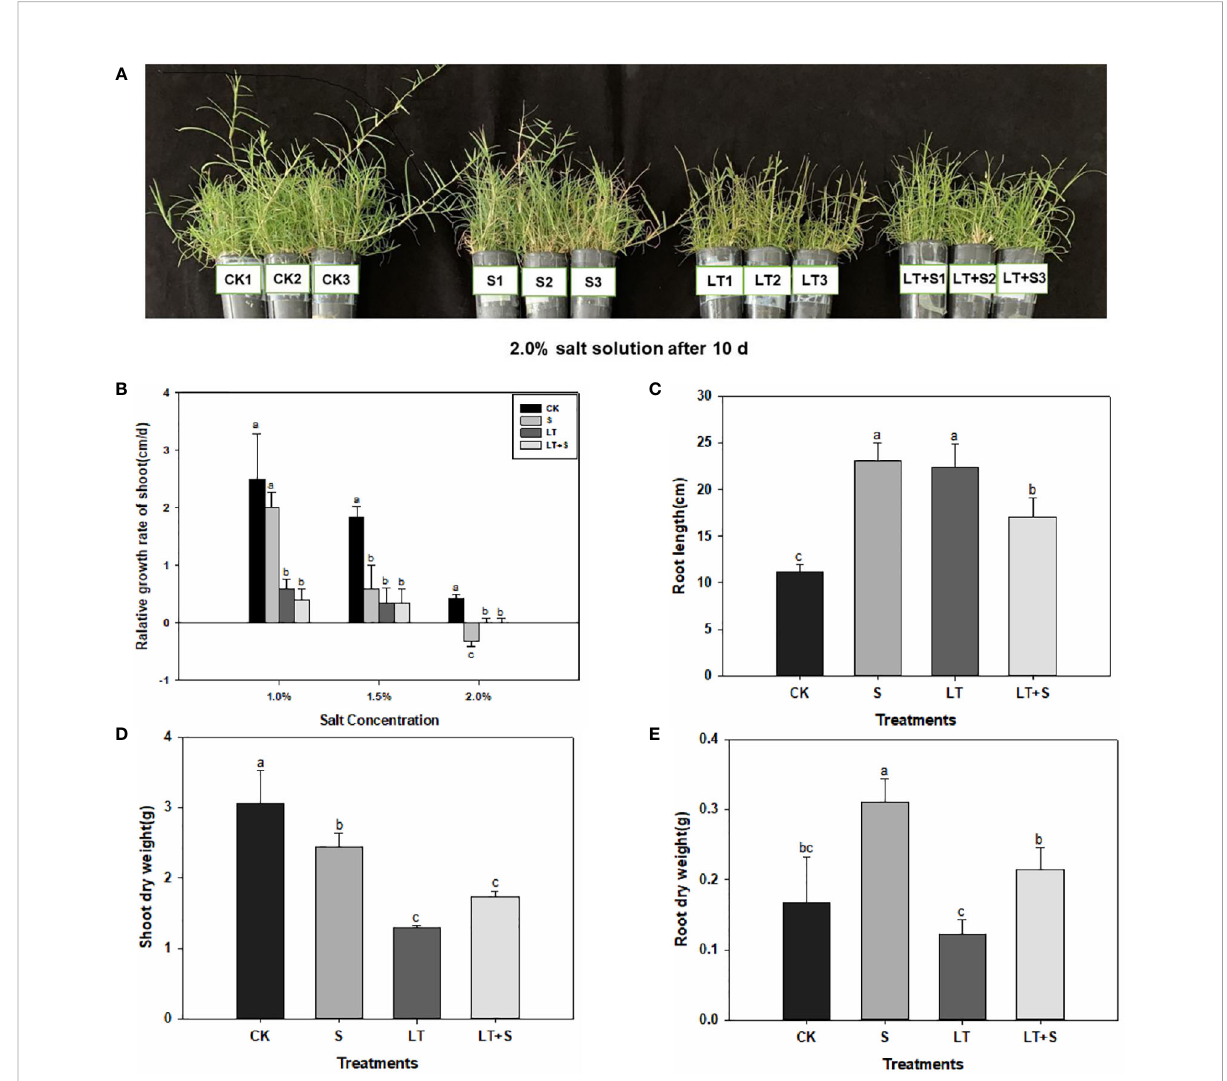
FIGURE 1 Bermudagrass phenotypic features under low temperature and salt stress. (A) Image of bermudagrass plants. (B) Relative growth rate of shoot. (C) Root length. (D) Shoot dry weight. (E) Root dry weight. Bermudagrass was transplanted into black plastic tubes after being clipped to a uniform length at the root. The plant height was reduced to the same height after a time of cultivation in a greenhouse. Duncan ’ s multiple range tests show that different letters above the same columns imply statistically signi fi cant differences at P <